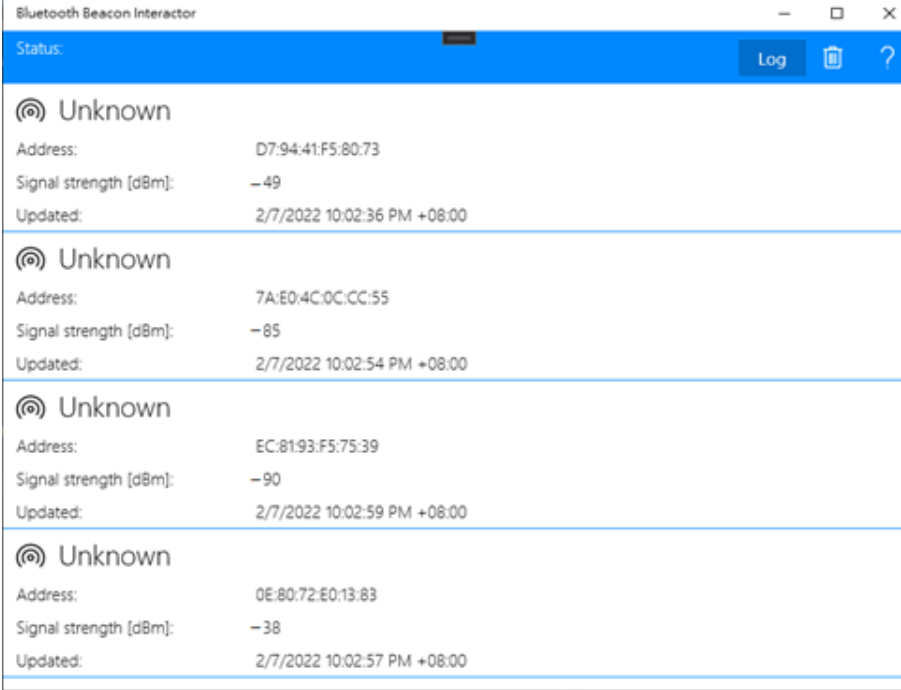
Table 1. Numerical analysis of various settings of Bluetooth signal.